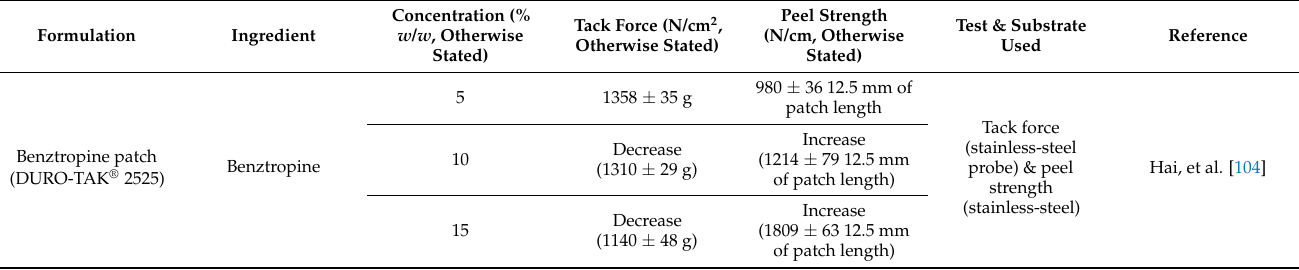
Table 5. Tack force and peel strength of patches with different formulations (CMC: